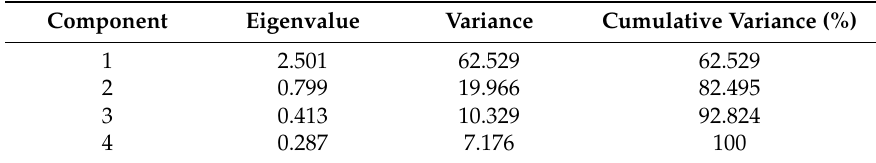
Table 3. Eigenvalues of principal component analysis of the four residual chronologies for the common period 1955–2015.